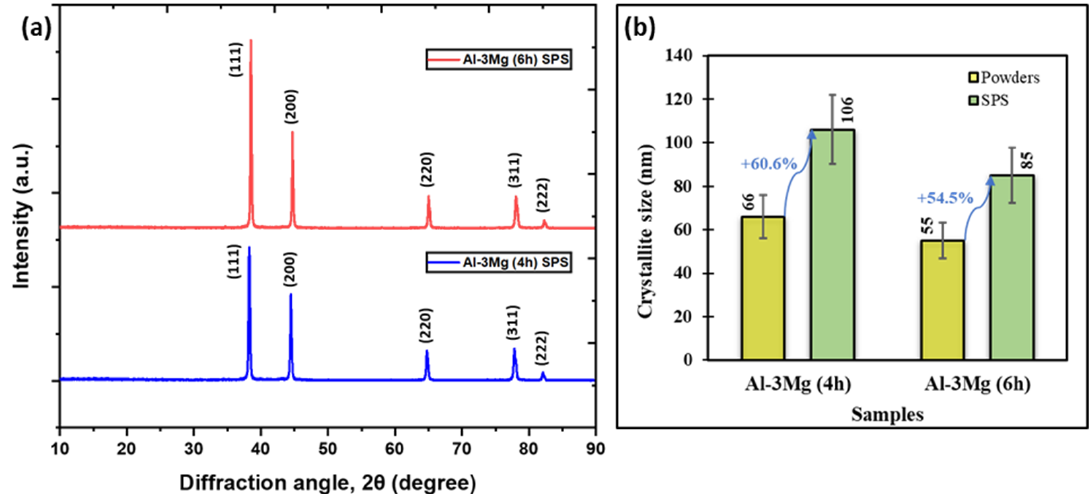
Figure 10. ( a ) XRD spectrum for Al-3Mg 4 h, Al-3Mg 6 h SPS samples and the ( b ) plot showing the effect of the SPS process on the crystallite sizes for pure Al and Al-3Mg samples for varying cryomilling duration.